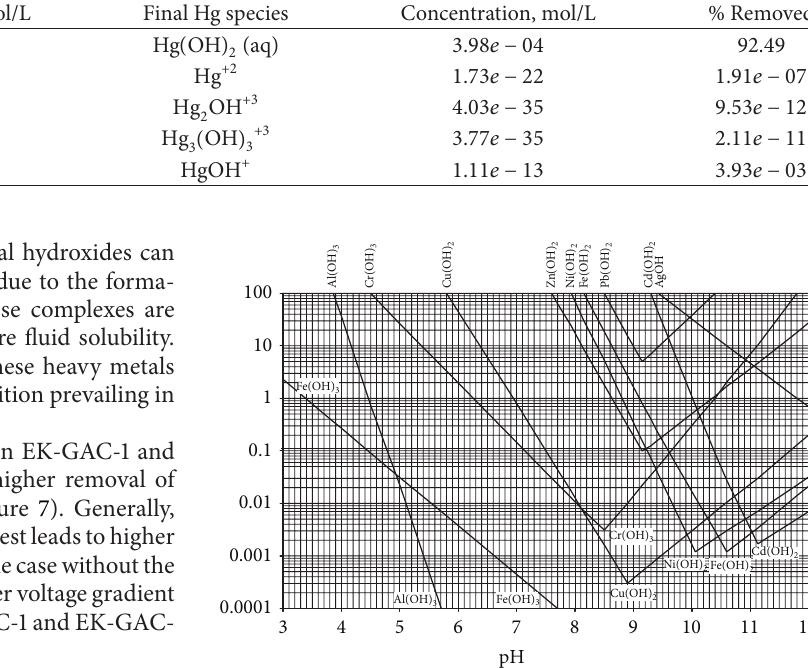
Figure 8: Variation of theoretical solubilities of some heavy metal hydroxides with pH